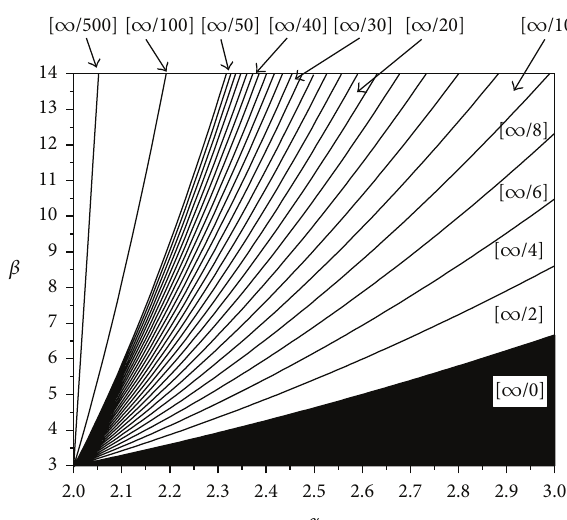
The function is positive for positive 𝑧 and as 𝑧 → −∞ the function oscillates with growing amplitude crossing the negative real axis an infinite number of times. The Mittag- Leffler functions in phase [ ∞/𝑓 ] differ from those in phase [ ∞/0 ] in that the functions in phase [ ∞ / 𝑓 ] exhibit a finite number of oscillations whose relative minima are above the negative 𝑧 -axis, whereas for functions in phase [ ∞/0 ], the relative minima for all oscillations are below the negative 𝑧 -axis (see Figure 12). For fixed 𝛼 , and 𝛽 incrementally above the phase boundary line, the relative minimum in the oscillation nearest 𝑧 = 0 no longer lies below the negative 𝑧 - axis but is now above the negative 𝑧 -axis and thus the function has lost two real zeros and gained two complex zeros (one and its complex conjugate). The phase boundary occurs